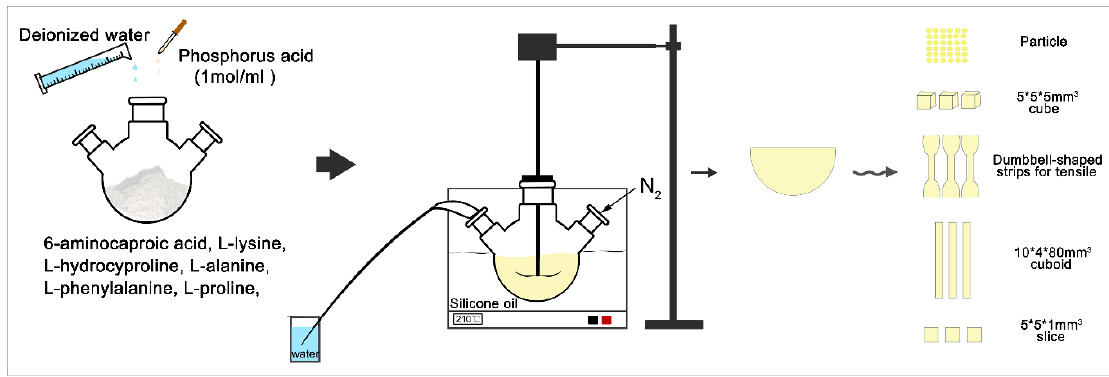
Figure 1. The P / PAA composite fabrication using in situ melting polycondensation Figure 1. The P/PAA composite fabrication using in situ melting polycondensation methods.